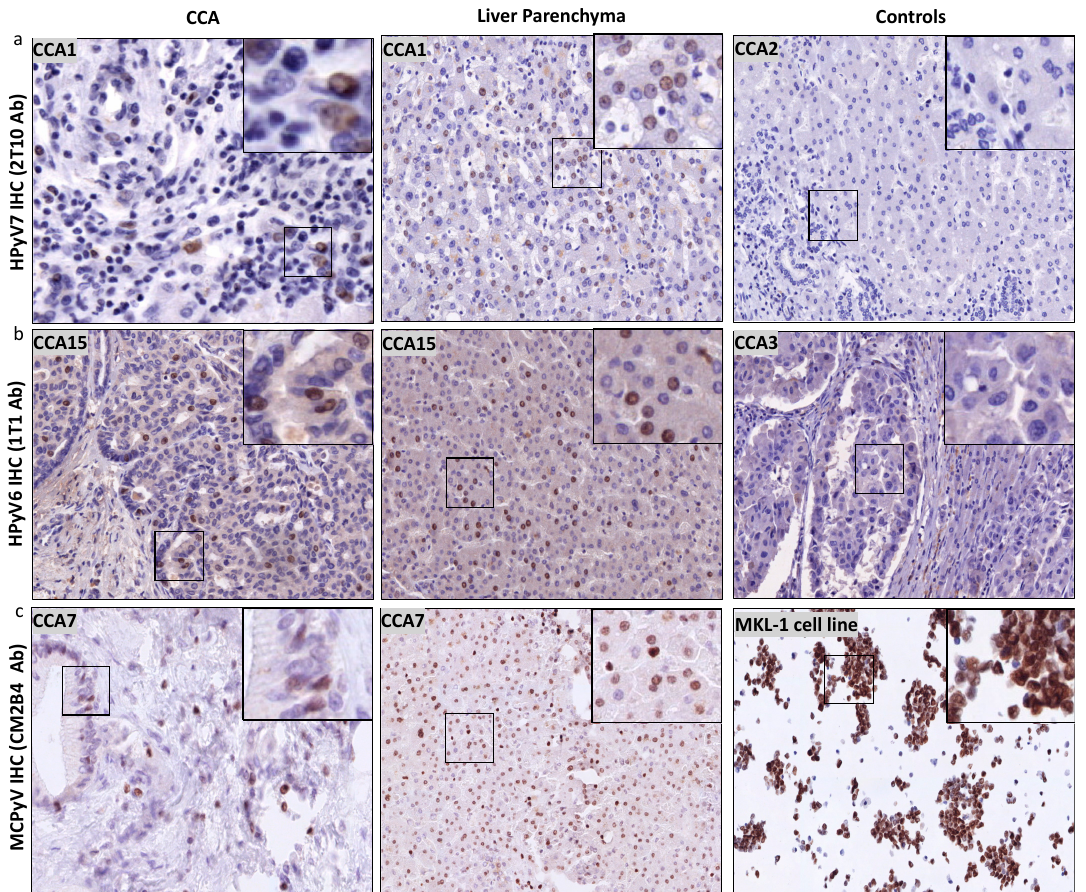
Figure 4. Detection of HPyV6, HPyV7, and MCPyV on the translational level in FFPE of CCA and non-neoplastic hepatocytes. ( a ) Representative examples of IHC using 2t10 antibodies showed the specific nuclear expression in the nucleus (brown) of both CCA and liver parenchyma. CCA2 tissue is an example of negative HPyV7. ( b ) In a representative IHC for CCA15 tissue, 1t1 antibodies show positivity in both CCA and hepatocytes, while no protein expression was seen in CCA3. ( c ) Example of results of IHC for MCPyV, specific nuclear expression (brown) of MCPyV (CM2B4 antibody) in the nuclei of CCA epithelial, and the non-neoplastic hepatocytes. MKL1 cell line served as a positive for MCPyV antibodies. The images were taken at 200x magnification, a black square area was magnified 6x in the top right corner of each